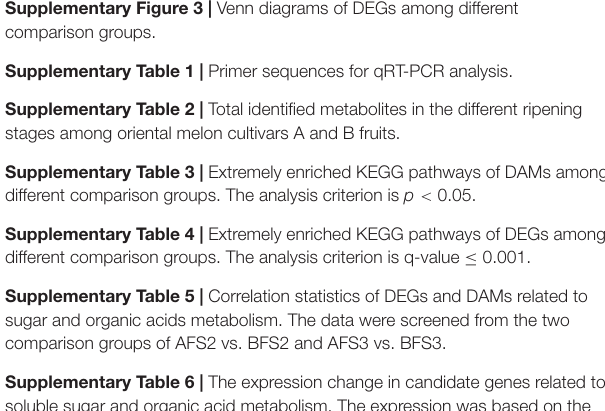
Supplementary Figure 1 | PCA of metabolomics data from three developmental stages of melon cultivars A and B fruits. QC (quality control) represents a mixture of all fruit samples. Supplementary Figure 2 | PCA of the transcriptomics data from three developmental stages of melon cultivars A and B fruits. Supplementary Figure 3 | Venn diagrams of DEGs among different comparison groups. Supplementary Table 1 | Primer sequences for qRT-PCR analysis.